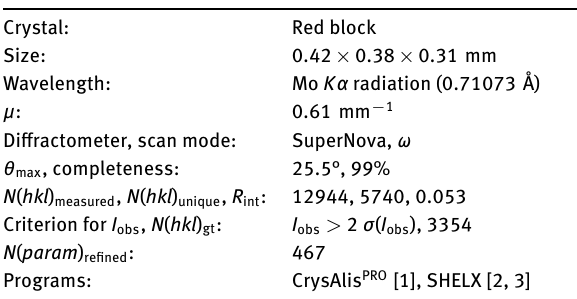
Table 1: Data collection and handling.